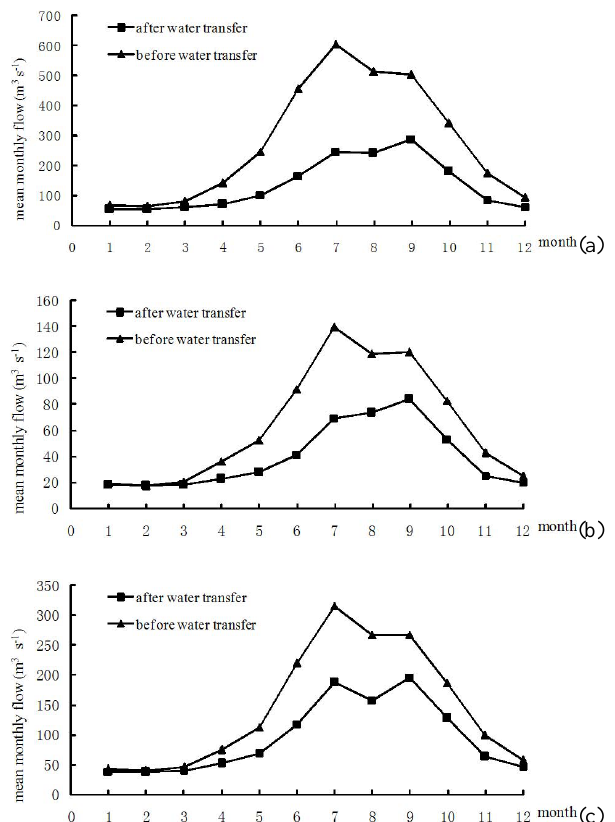
Fig. 6. Comparison of the mean monthly flow of some typical river sections before and after water transfer. (a) Ganzi section in Yalong River, (b) Zhuba section in Niqu River and (c) Daofu section in Xianshui